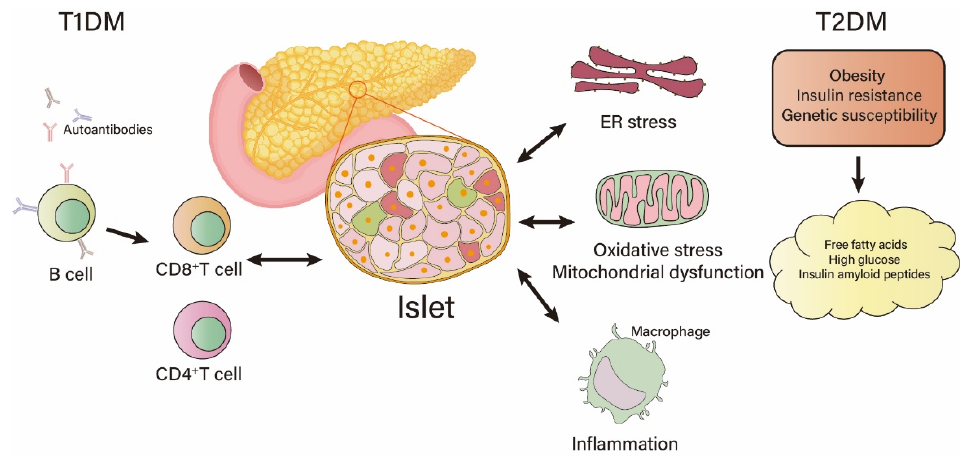
Figure 1. Islet β -cell dysfunction during the pathogenesis of type 1 diabetes mellitus (T1DM) and type 2 diabetes mellitus (T2DM).